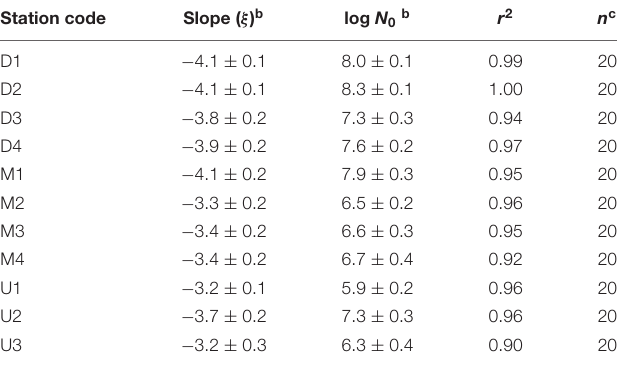
TABLE 4 | Parameters of particle size distribution of each regression line a . Station code